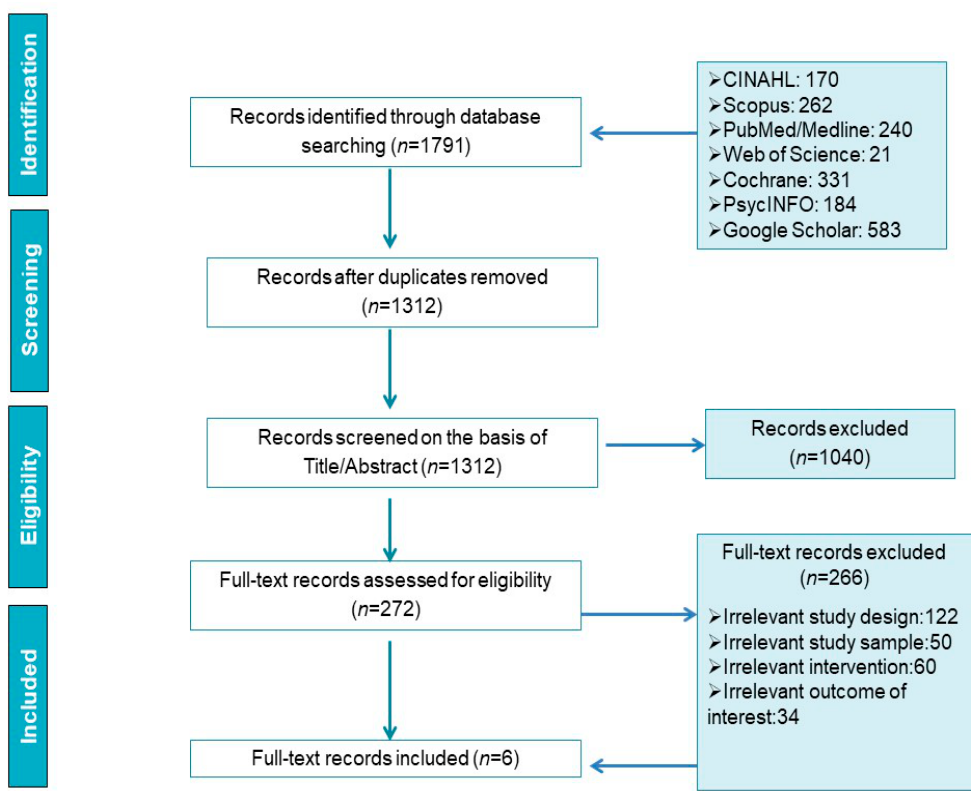
Figure 1. Flow diagram of the search process.